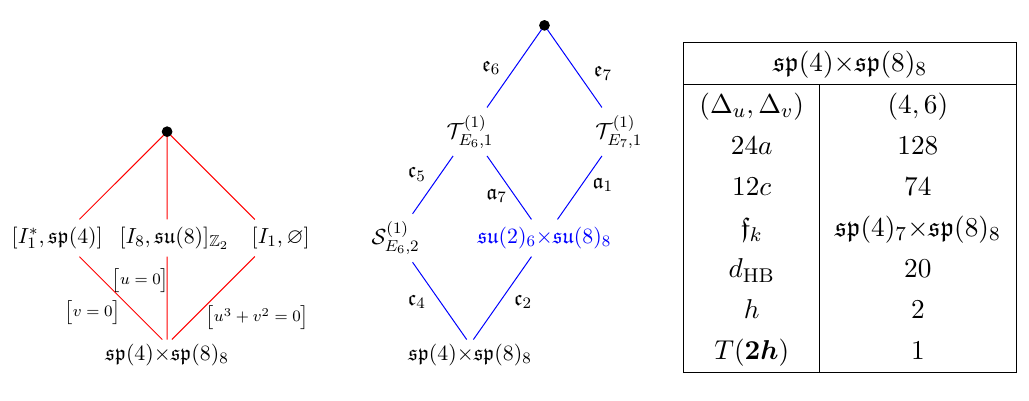
Figure 16. Information about the sp (4) × sp (8) 8